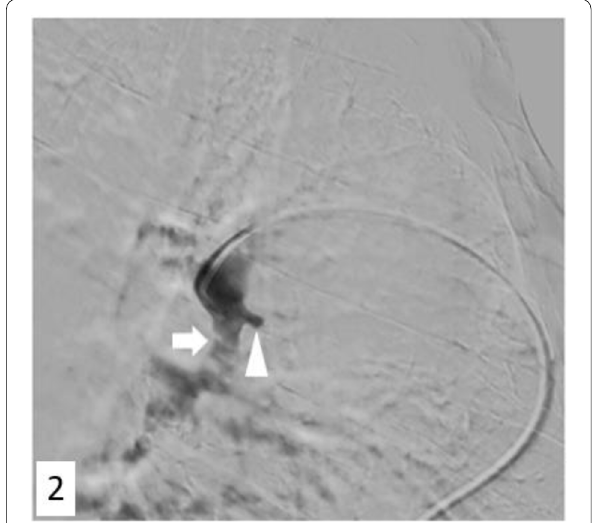
Fig. 2 Left pulmonary artery angiography confirming the pseudoaneurysm location. Axiom Artis Q, Siemens Healthineers